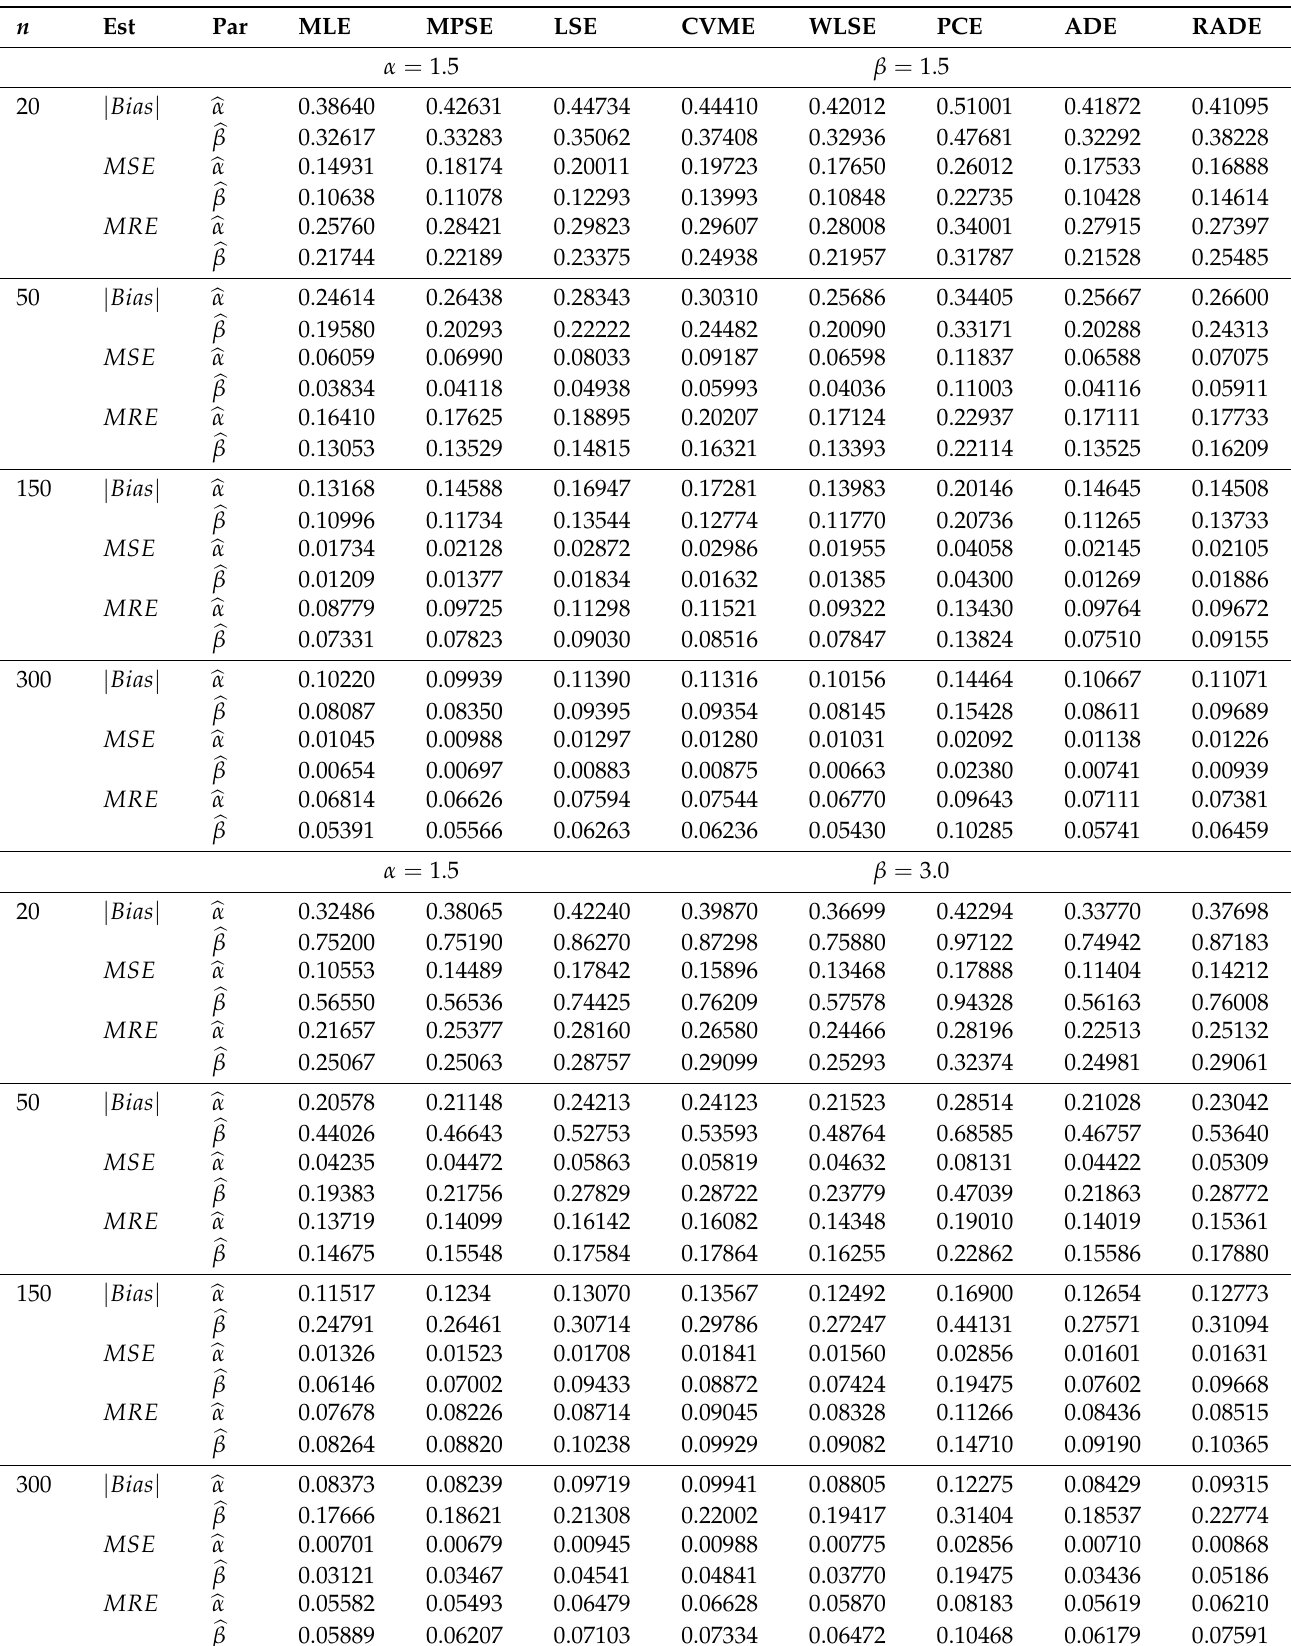
Table 5. Simulation results of the eight estimation methods for α = 1.5 and β =